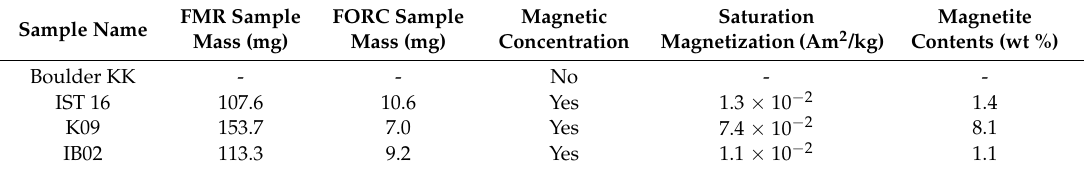
Table 1. Summary of sample mass, magnetic concentration, and magnetite contents for FMR and FORC